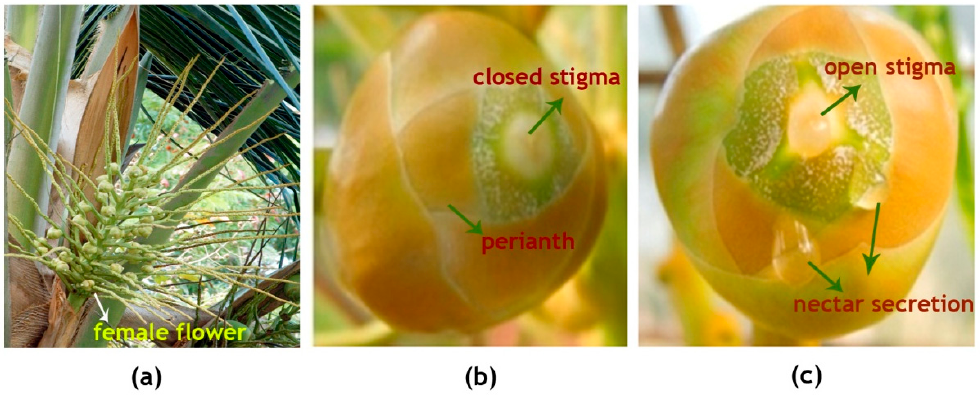
Figure 2. Fully opened inflorescence of the coconut variety West Coast Tall (WCT) showing ( a ) female flowers at the base of rachilla while all the male flowers were already shed,( b ) a female flower few days before its receptivity and ( c ) a receptive female flower with moist open stigma and nectar secretion from the orifice. Table 1. Effect of high temperature stress on female flower receptivity and the visual changes observed at the stigmatic surface of the field-grown coconut variety WCT. The inflorescence was exposed to temperature and RH treatments six days before flowers were to become receptive and the visual observations were recorded daily. Data are presented as mean ± SD of female flowers from three inflorescences.